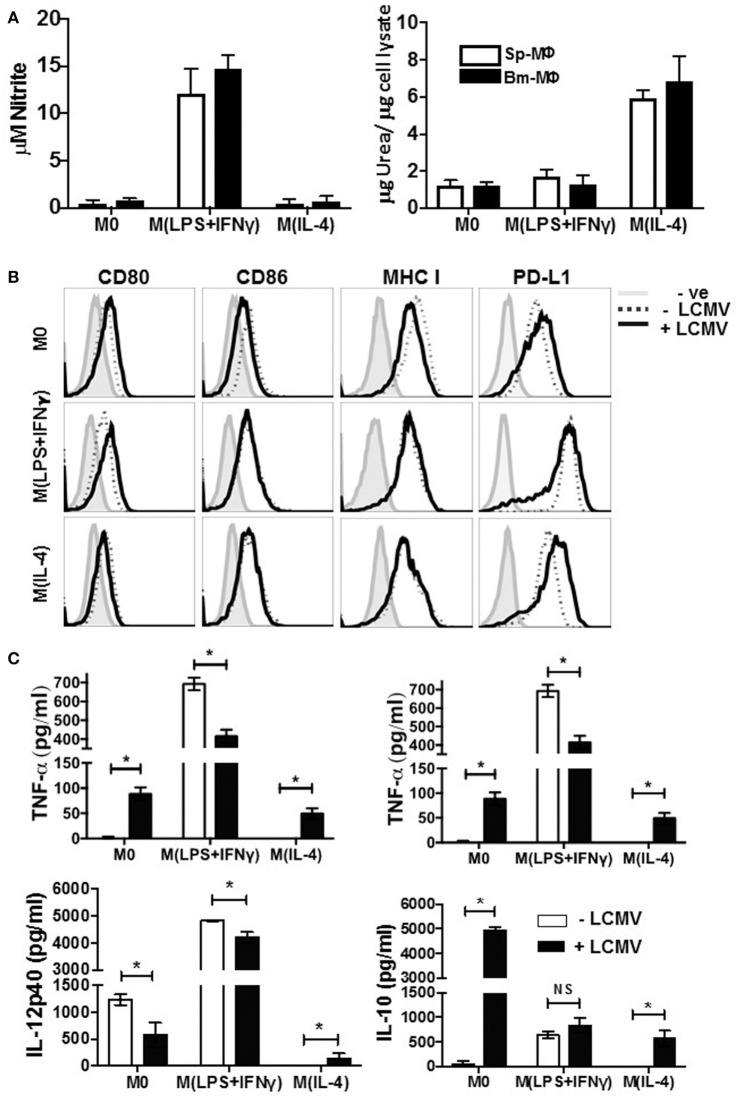
Immunophenotyping of polarized macrophages. Activated BM-MΦ or Sp-MΦ populations were polarized into M(LPS + IFN-γ) (25 ng/mL IFN-γ + 100 ng/mL LPS), or M(IL-4) (20 ng/mL IL4) or left unstimulated. (A) Nitrite detection after BM-MΦ or Sp-MΦ were polarized into M(LPS + IFN-γ) or M(IL-4), or left unstimulated (left panel). Supernatants were collected before testing them for nitrite production using the Greiss reaction. The OD was measured using Varioskan plate reader to quantify nitrite production after comparing the values to the standard curve. In the right panel, urea production was measured in polarized BM-MΦ and Sp-MΦ samples to monitor arginase activity indicative of M(IL-4) polarization. Values are represented as μg urea corrected to μg cell lysate. Data shown and error bars are the mean ± SD from one representative experiment out of three. (B) Staining profiles of activated polarized BM-MΦ and Sp-MΦ populations that were either controls or infected with LCMV-WE (MOI 5 for 24 h). Histograms show surface staining for CD80, MHC-86, MHC-I, or PD-L1 in the various MΦ populations compared with the isotype control (−ve). Data shown are representative from one of two experiments. (C) Cell supernatants from LCMV-uninfected or LCMV-infected (24 h) polarized Sp-MΦ were subjected to ELISA for quantification of TNF-α, IL-12p40, IL-6, and IL-10. Graphical data show mean ± SD from two independent experiments containing two experimental replicates. BM, bone marrow; MHC, major histocompatibility complex; LCMV, lymphocytic choriomeningitis virus infection; LPS, lipopolysaccharide.